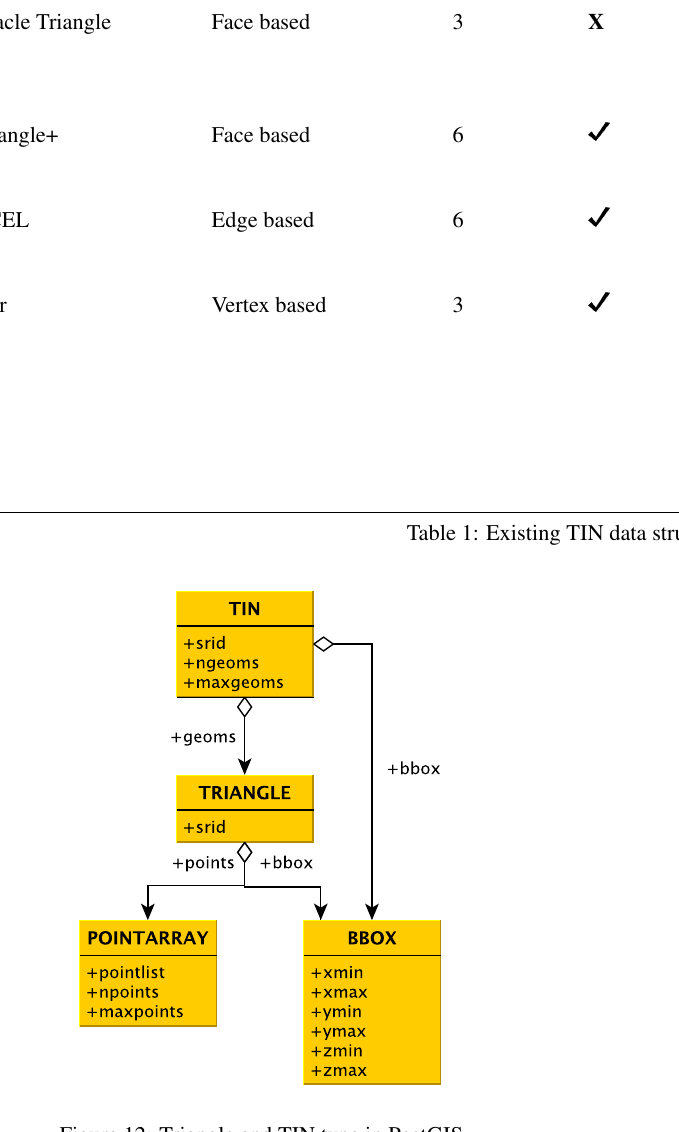
Figure 12: Triangle and TIN type in PostGIS